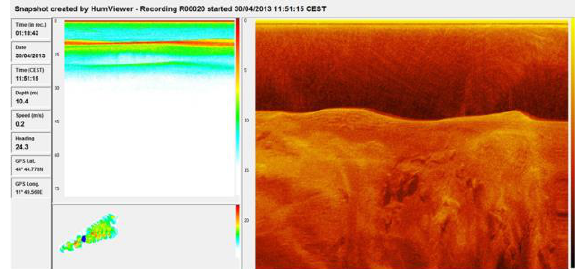
Figure 12. Gambulaga – Portomaggiore (FE), Tramonto Lake, snapshot with wooden piles.